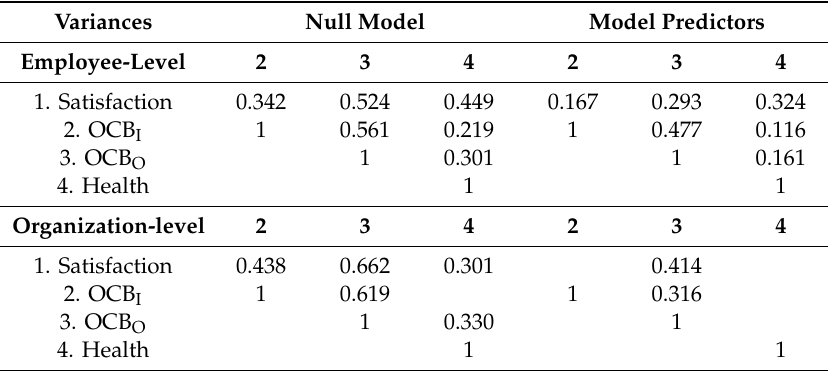
Table 5. Correlation between the random model parameters.